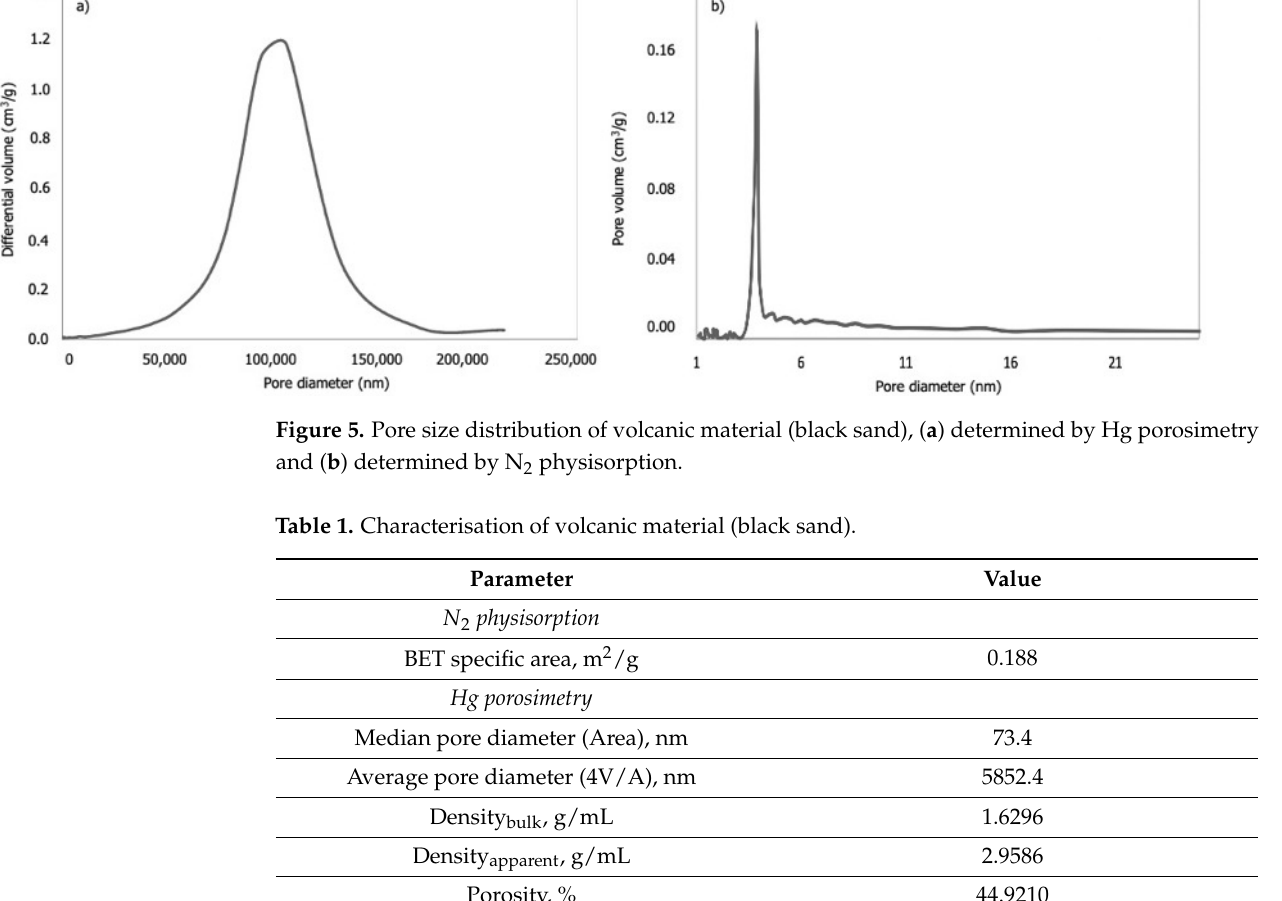
Figure 5. Pore size distribution of volcanic material (black sand), ( a ) determined by Hg porosimetry and ( b ) determined by N 2 physisorption. Table 1. Characterisation of volcanic material (black sand).